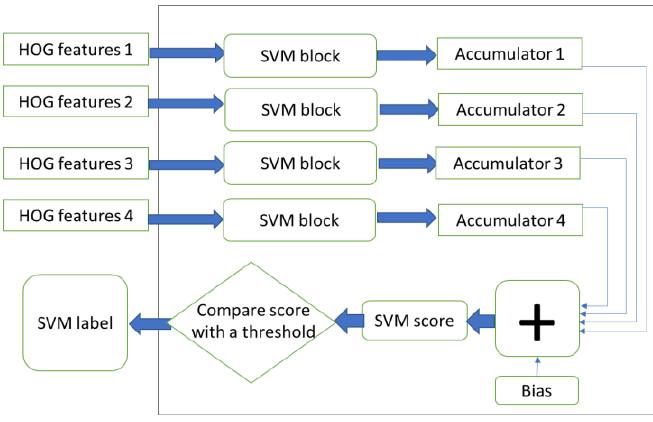
Figure 14. The SVM classifier module.